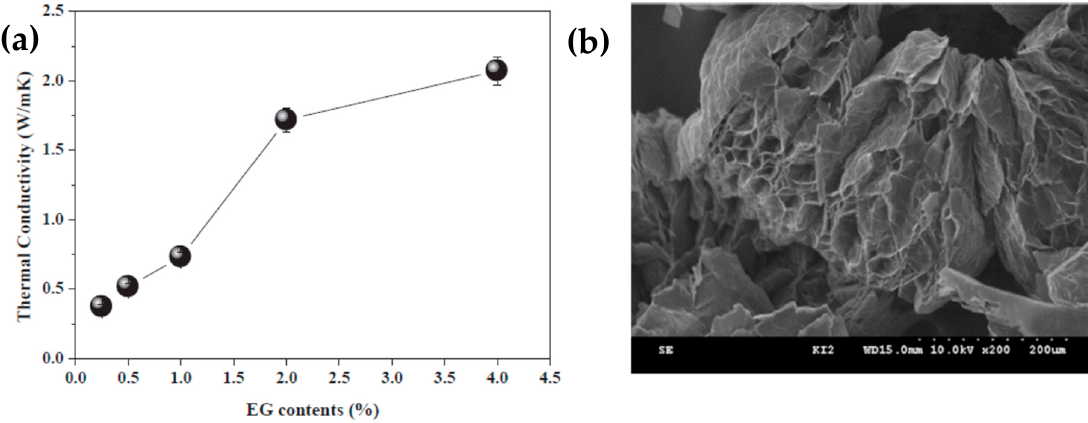
Figure 4. ( a ) Thermal conductivities of the erythritol/expanded graphite composites as a function of the EG content and ( b ) SEM image of the worm-like and porous EG.